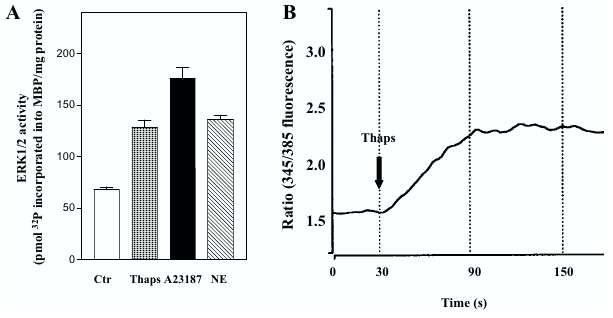
Figure 1 ERK1/2 activation and Ca 2+ response in hepatocytes. A: At 3 h after the time of seeding hepatocytes were preincubated with timolol (10 µ M) for 30 min prior to stimulation with thapsigargin (1 µ M), A23187 (10 µ M) or norepinephrine (10